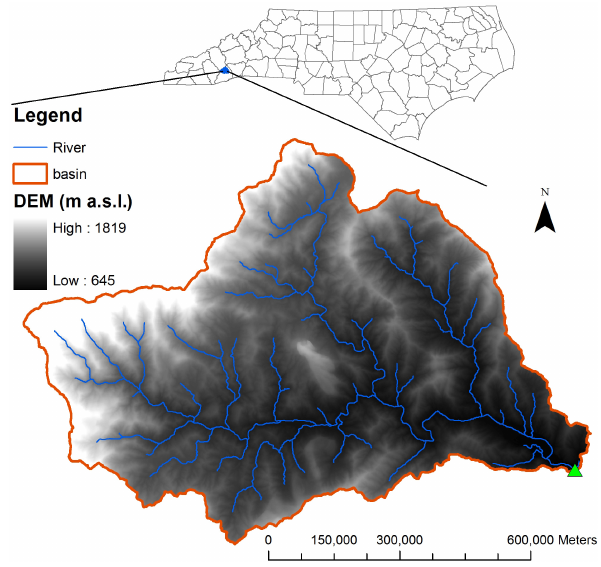
Figure 2. The location of the Davidson watershed, North Carolina, with a DEM map, the river system (lines), and the watershed outlet (the triangle